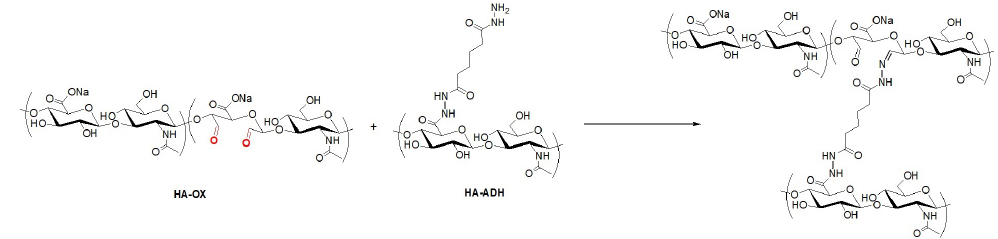
Figure 3. Schiff base formation between HA-OX and HA-ADH. Table 1. List of prepared hydrogel samples and their compositions as indicated by the checkmarks at respective components.